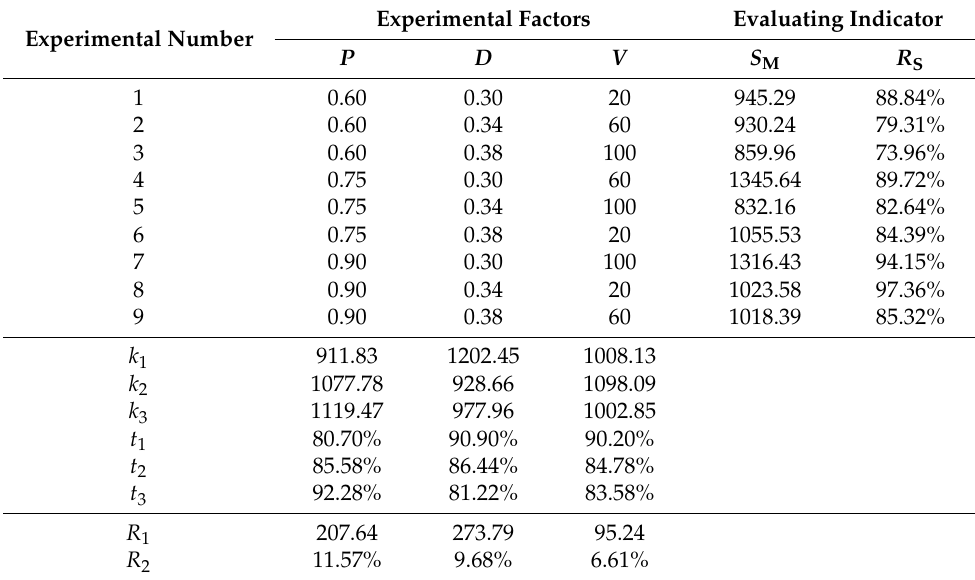
Table 3. Results of deviation tolerance orthogonal experiment. Experimental